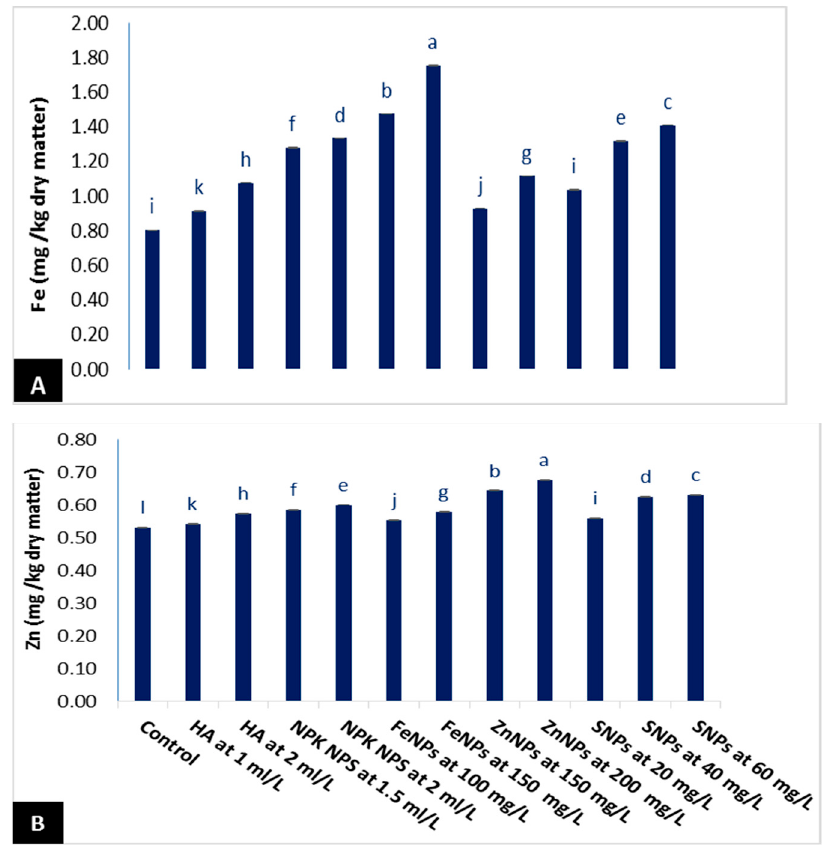
Figure 2. Effect of nanoparticles and humic acid on Iron ( A ) and Zinc content ( B ) (mg/Kg DW) content in Philodendron bipinnatifidum during 2019/2020 and 2020/2021 seasons. The same letters show no significant differences between the treatments according to ANOVA, Duncan’s multiple range test at 0.05 level. Data are the mean of both seasons (±SE) of three replicates.